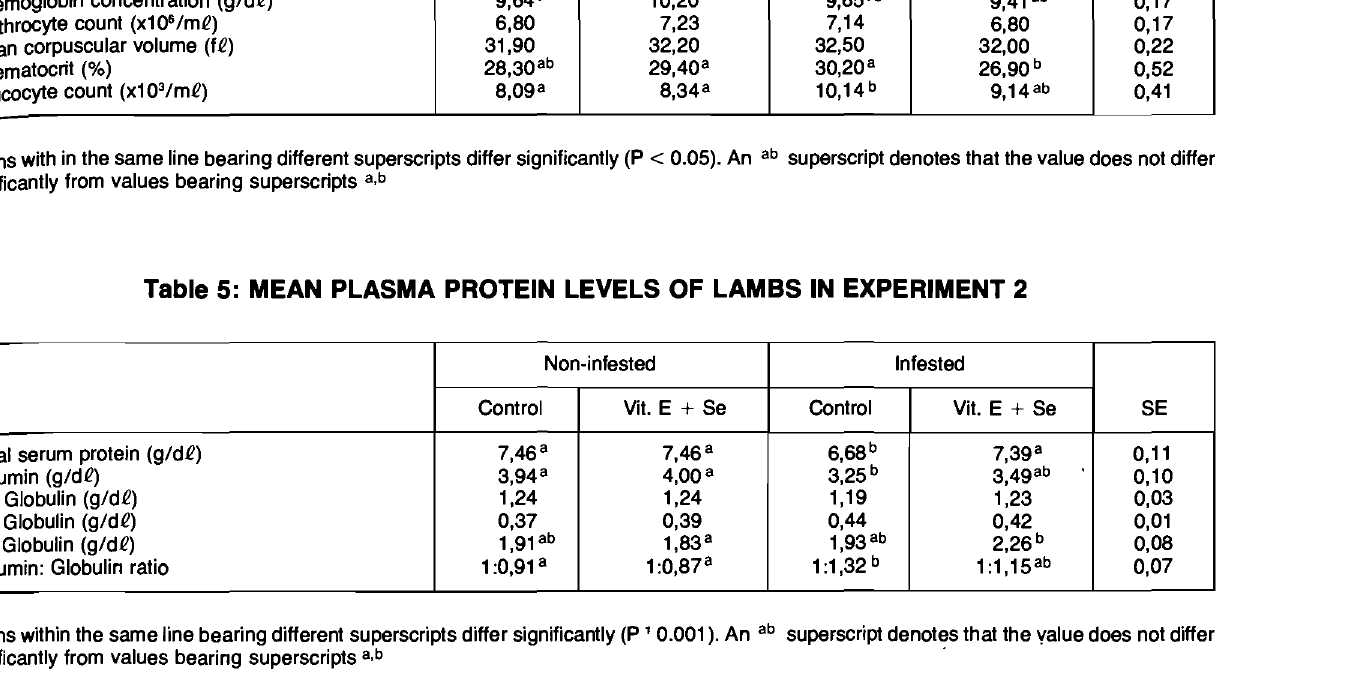
Table 4: MEAN RESULTS OF HAEMATOLOGICAL INVESTIGATIONS ON LAMBS IN EXPERIMENT 2 ..-- Haemoglobin concentration (g/dR)